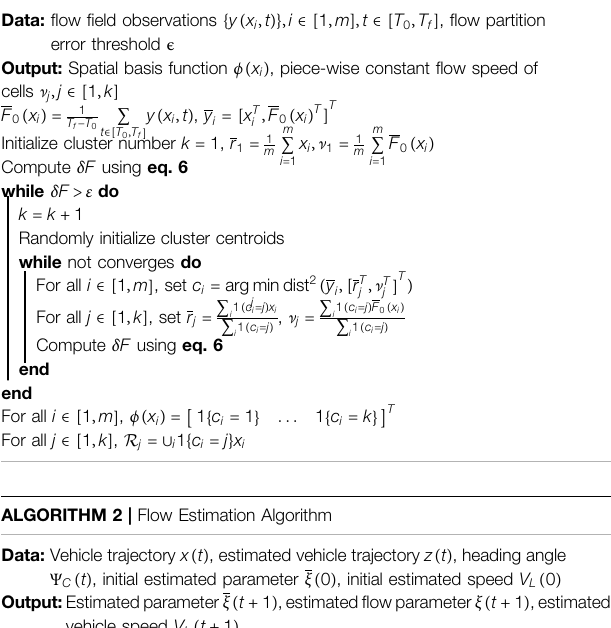
1 | Flow Field Partition